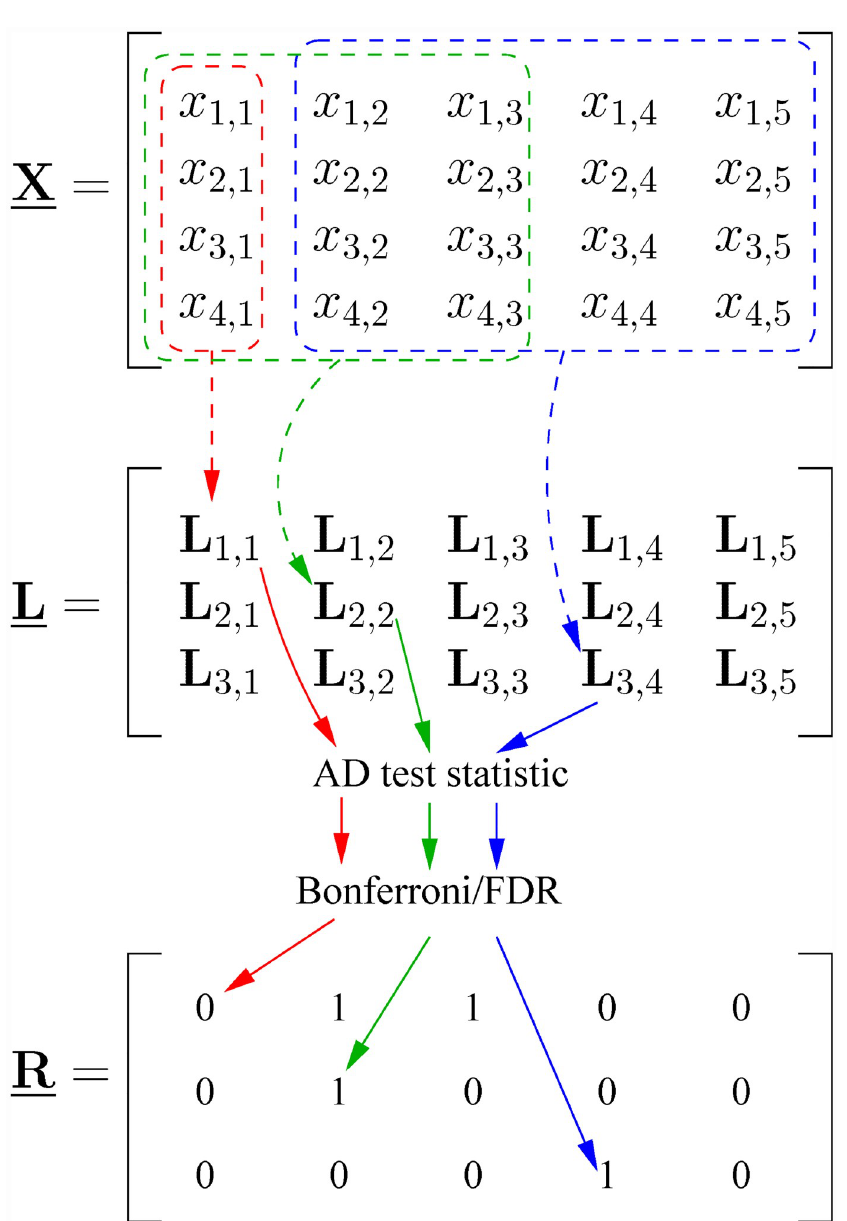
Fig 4. Workflow chart. The data matrix X has dimensions [ n , p ] = [4, 5]. The summation matrix L has dimensions [ n , p , n ] and each L is a vector of length n . The significance matrix R has dimensions [ n s s , d spans one dimension, indicates that for the lowest resolution value, no summation is performed across the dimensions. For the green and blue boxes, summation is performed across dimensions 1–3 and 2–5, respectively. The blue box is adjusted to not extend outside the data matrix. Note that two significance maps are produced, one each for the Bonferroni/FDR approaches, with ones in R marking rejections of the null hypothesis for the corresponding resolutions and positions. When plotting the significance maps, the vertical axis is inverted.